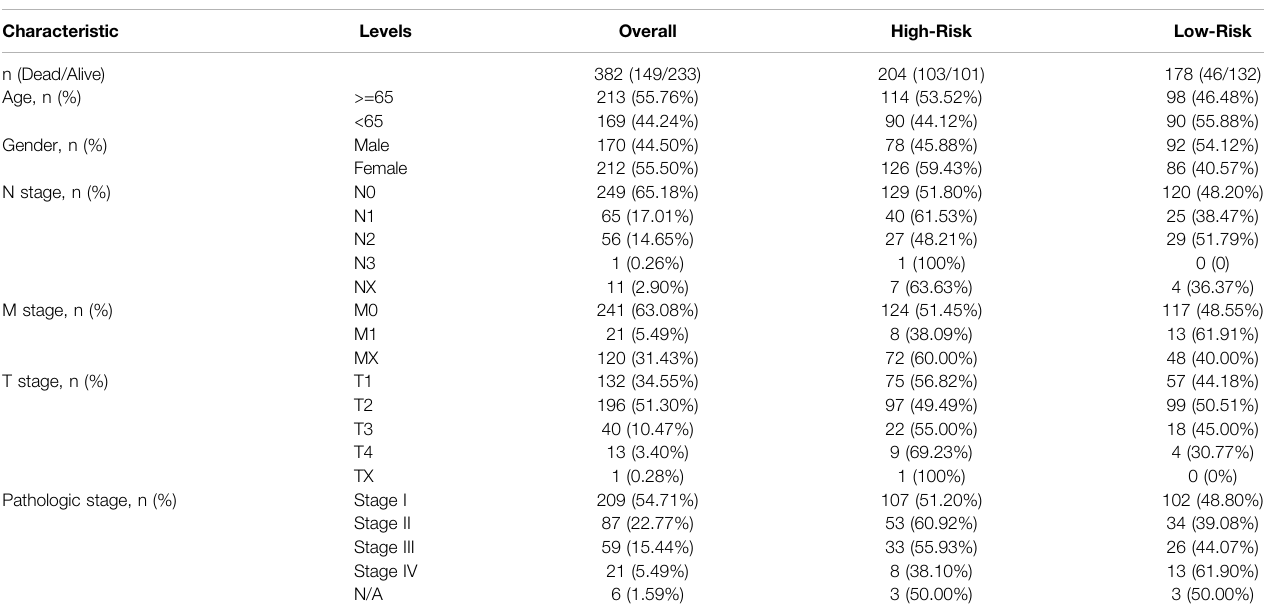
TABLE 2 | The clinical index of LUAD patients used in the Cox model.